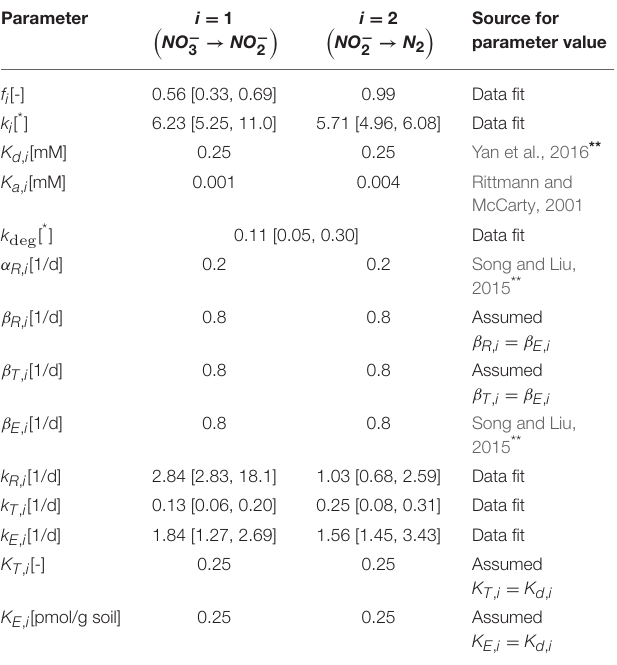
TABLE 1 | Model parameter values used for the simulation of the two-step denitrification process. Parameter